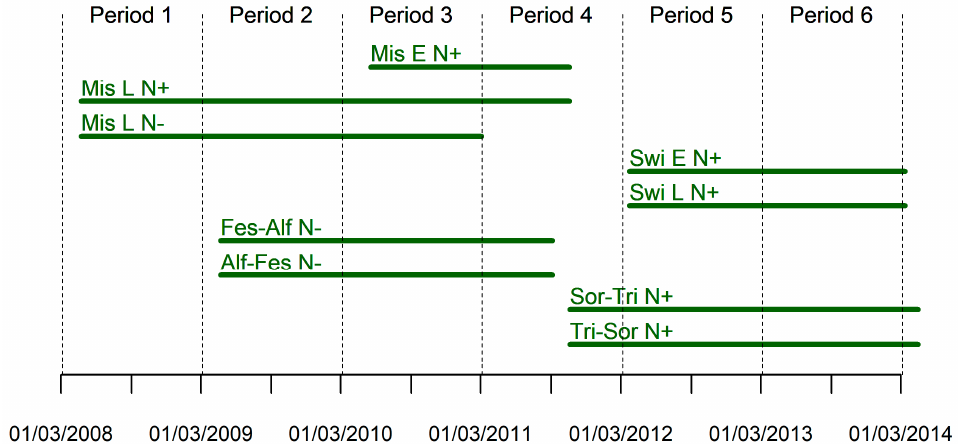
Figure 1. Timeline of N 2 O measurements for the studied treatments of the B&E experiment.